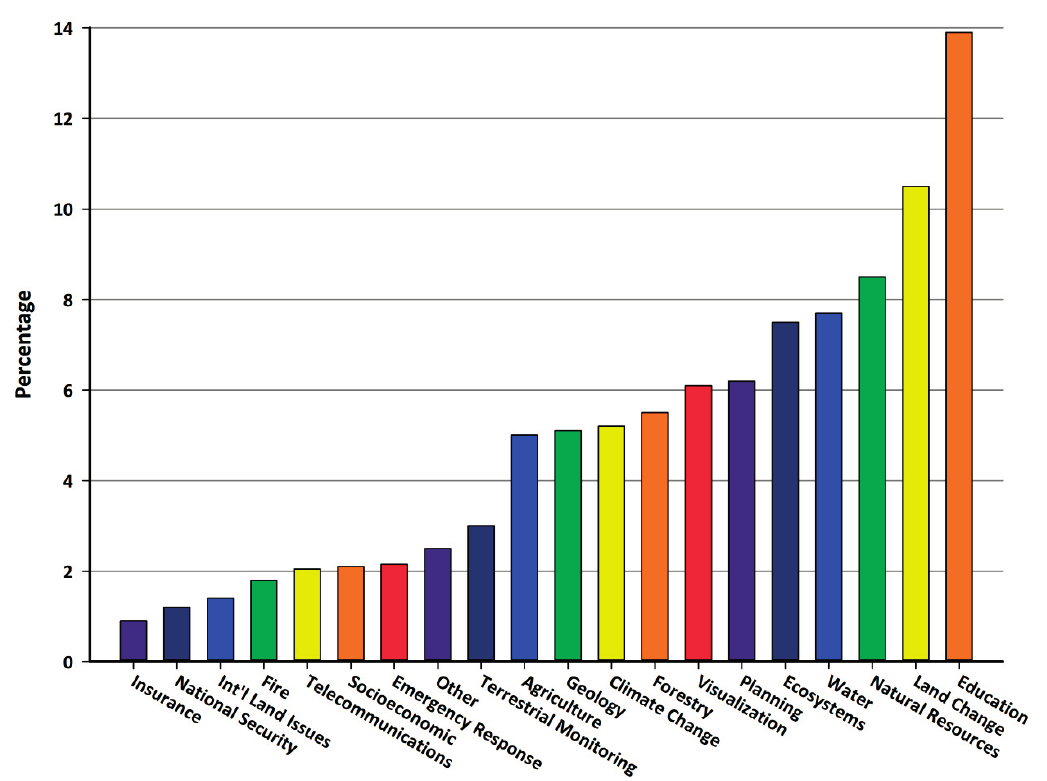
Figure 2. NLCD user applications by category based on USGS earth explorer downloads from February 2011 to September 2012 (N =